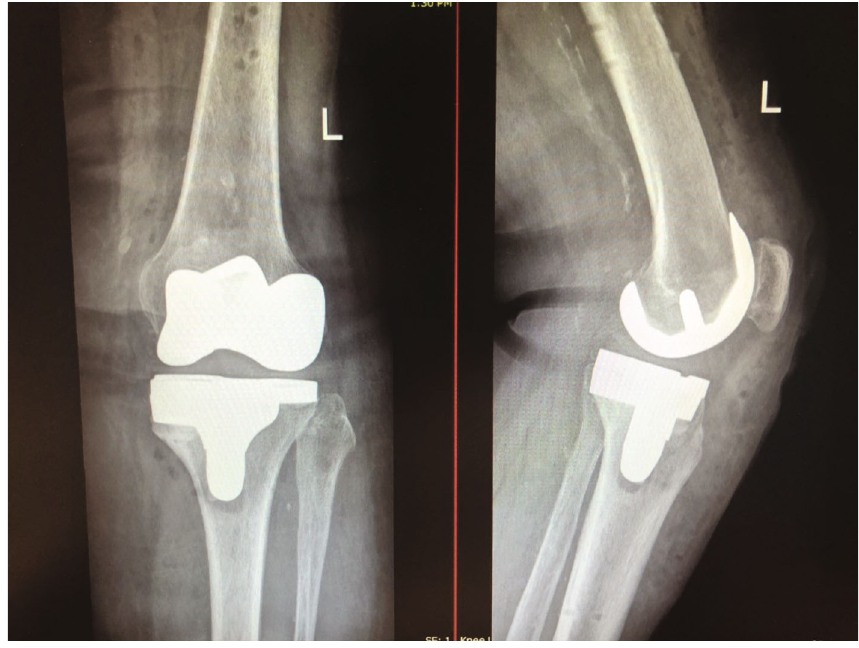
Figure 3: Postoperative anteroposterior and lateral X-ray